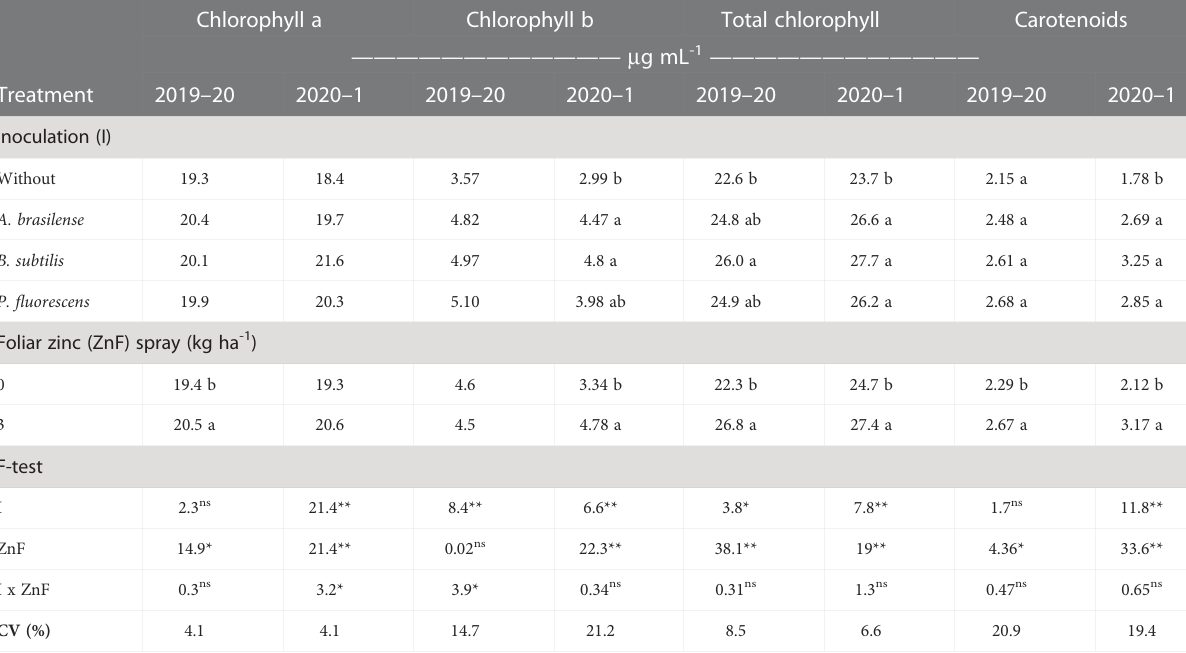
TABLE 5 Photosynthetic pigment of maize leaves as a function of plant growth-promoting bacteria inoculation, together with or without nano- zinc oxide spray, in the 2019 – 20 and 2020 – 1 cropping seasons.